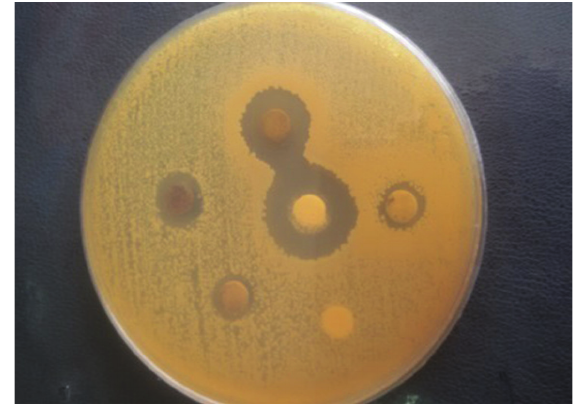
O FIGURE 3 - Disc diffusion methods and their hollows around 3 4 discs against S. aureus.